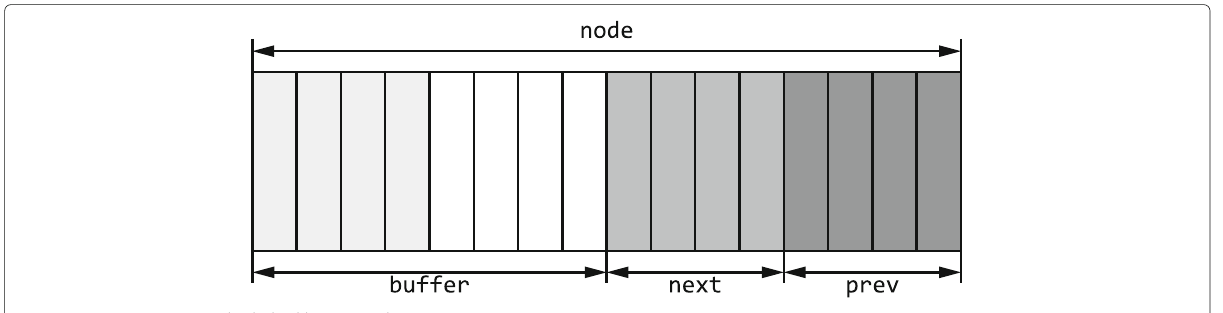
Fig. 5 Memory ranges in the linked list